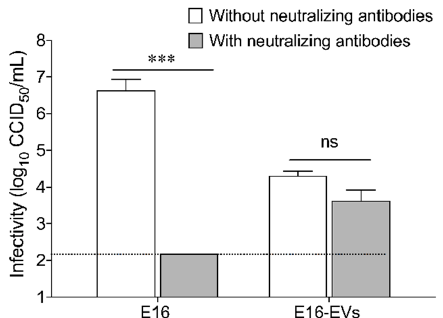
Figure 5. EVs-mediated E16 infection of EndoC- β H1 cells is not inhibited by virus-specific neutralizing antibodies. Free virus (E16) and EVs from E16-infected EndoC- β H1 cells (E16-EVs) were incubated with or without anti-E16 neutralizing antibodies. Titration of viral production in the presence or absence of neutralizing antibodies was determined as described in the materials and methods. Dotted black lines indicate the limit of detection. Data are representative of three independent experiments, with each measurement performed in triplicate (mean ± SEM). *** p < 0.001.